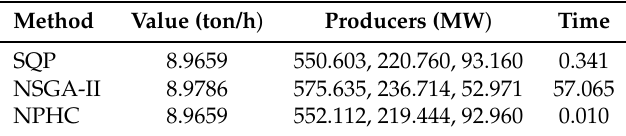
Table 2. Minimization of SO 2